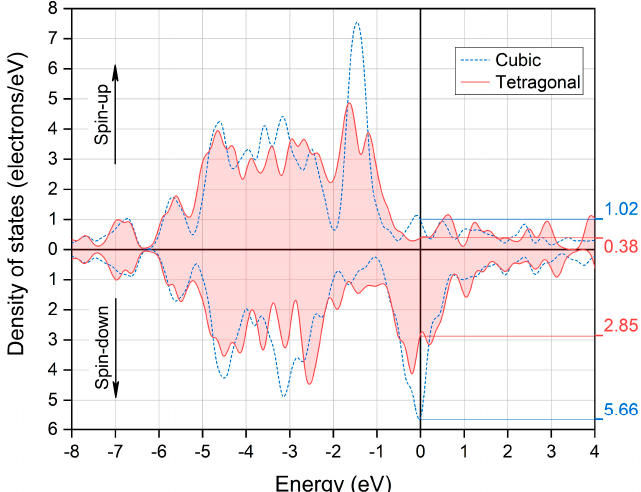
Figure 8. The calculated total densities of states for the full Heusler compound Pd 2 CoAl in L2 1 -type cubic and tetragonal structures.